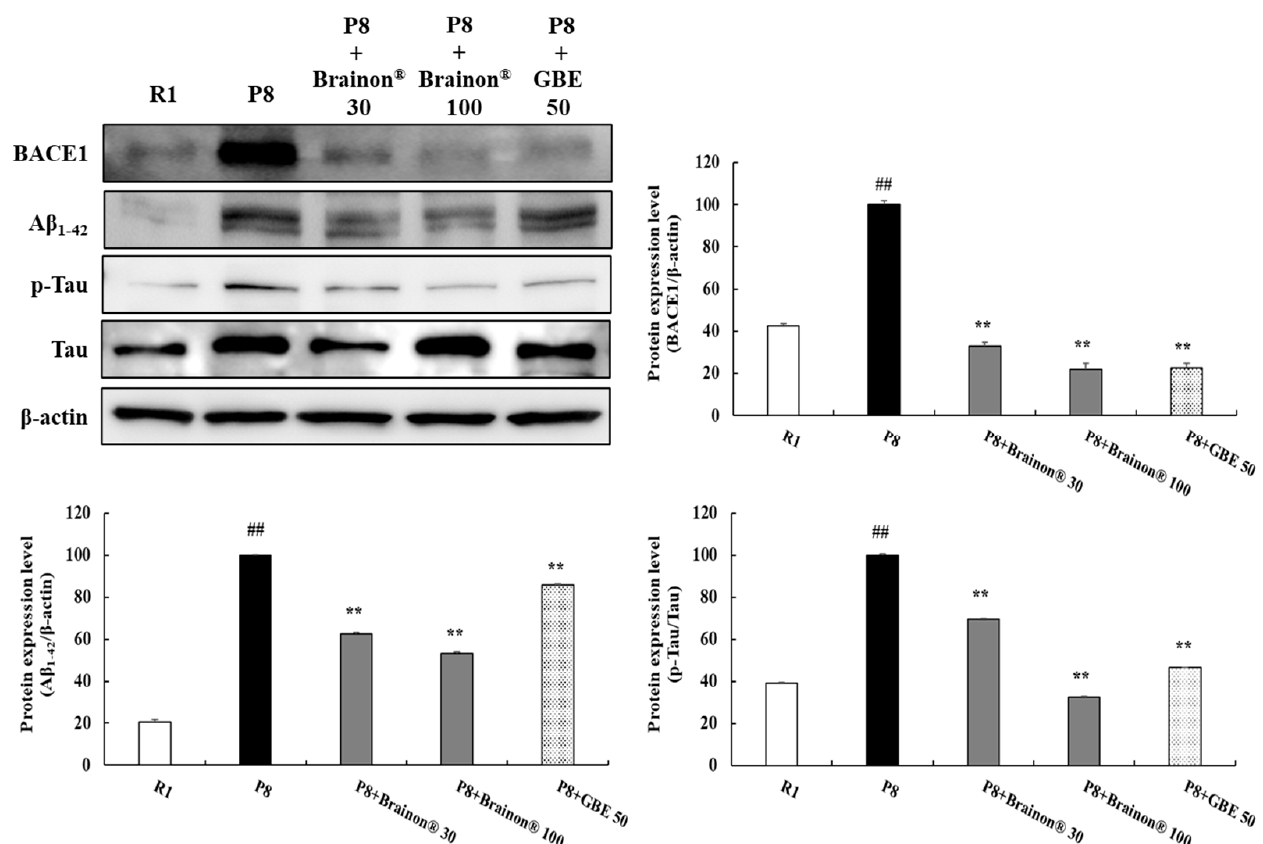
Figure 5. Effects of Brainon ® on inhibition of A β 1–42 production and hyperphosphorylation of Tau in the cerebral cortex of SAMP8 mice. BACE1 (70 kDa), A β 1–42 (4–46 kDa), p-Tau (50–80 kDa), and Tau (50–80 kDa) proteins were analyzed using Western blotting. The density of the protein band was measured using the ImageJ program. Protein was normalized with β -actin (45 kDa). Values are presented as mean ± SD ( n = 3). ## p < 0.01 vs. R1 (SAMR1) group; ** p < 0.01 vs. P8 (SAMP8)